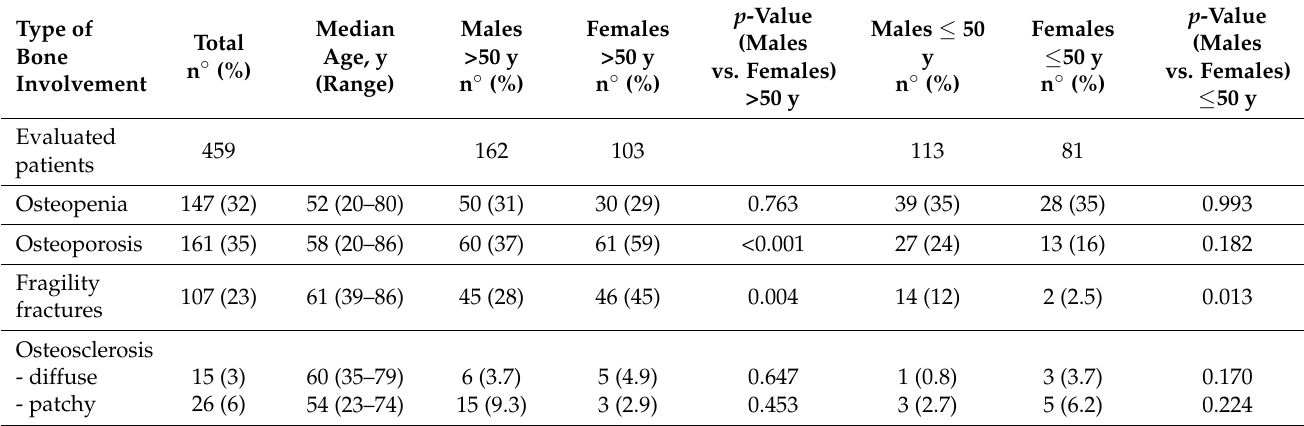
Table 4. Bone involvement in clonal mast cell disorders according to gender and